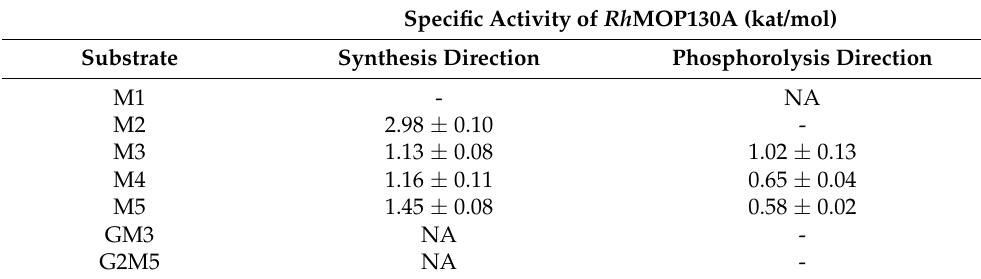
Table 1. The specific activity of the β -mannan-oligosaccharide phosphorylase Rh MOP130A in synthesis and phosphorolysis reaction